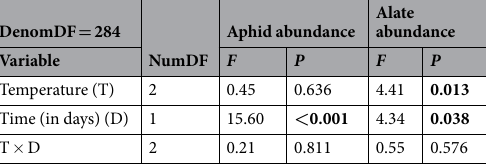
Table 1. Statistical results in the warming experiment: effects of temperature treatment and time on aphid and alate abundance. The statistical analysis applied linear model using generalized least squares (GLS) with AR1